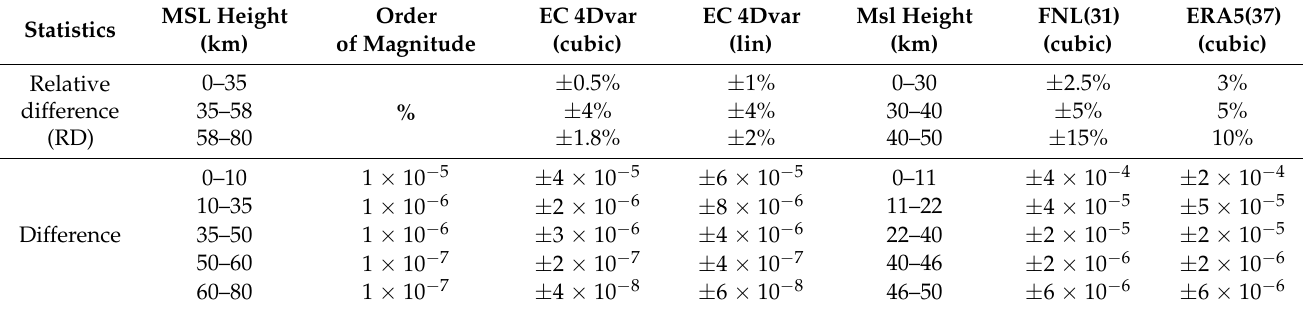
Figure 7. Under various model levels, the difference ( a – c ) and RD ( d – f ) of FM based on the exp algorithm and log-cubic interpolation. The RD for EC4Dvar below 35 km is less than ± 0.5%, whereas RDs for FNL and ERA5 below 35 km are less than ± 5%. Above 35 km, the RD for EC4Dvar is less than ± 5%, while RDs for FNL and ERA5 are up to 10%. Table 2. RD and difference for forward modeled analyses in MLS (mean sea level,